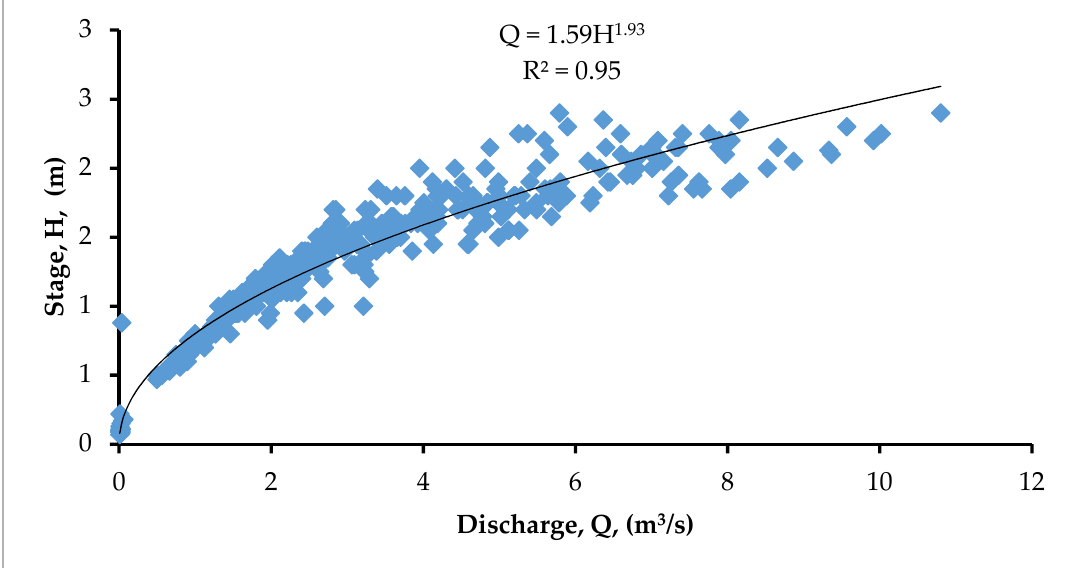
rainy seasons of 2015, 2016, and 2017, were 8.9, 10.7, and 11.2, respectively (Figure 8). The associated maximum base flow rates (m 3 /s) for 2015, 2016, and 2017 were 3.4, 4.7, and 4.8, respectively. The recharge and streamflow discharge reached their maximum values in Figure 6. Monthly runoff ( left ) and rainfall ( right ) values during the study period (2015 to 2017). 2017. Q = 1.59H 1.93 R² = 0.95